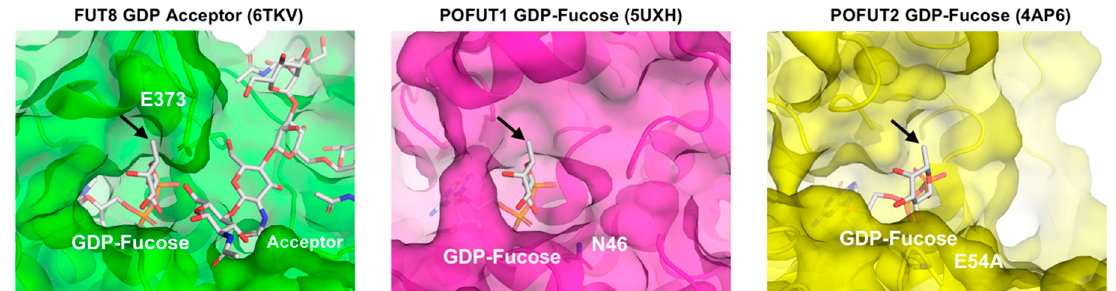
Figure 6. Structural comparison among FUT8-GDP-acceptor complex (PDB code: 6TKV, green), POFUT-GDP-Fuc complex (PDB code: 5UXH, magenta) and POFUT2-GDP-Fuc complex (PDB code: 4AP6, yellow). Protein molecules are shown in semi-transparent surface and ribbon models. Acceptor and GDP-Fuc are shown in stick models. The catalytic residues, E373 (FUT8), N46 (POFUT1) and E54 (POFUT2), located at the rim of catalytic center are labeled. An arrow indicates C6 of Fuc.